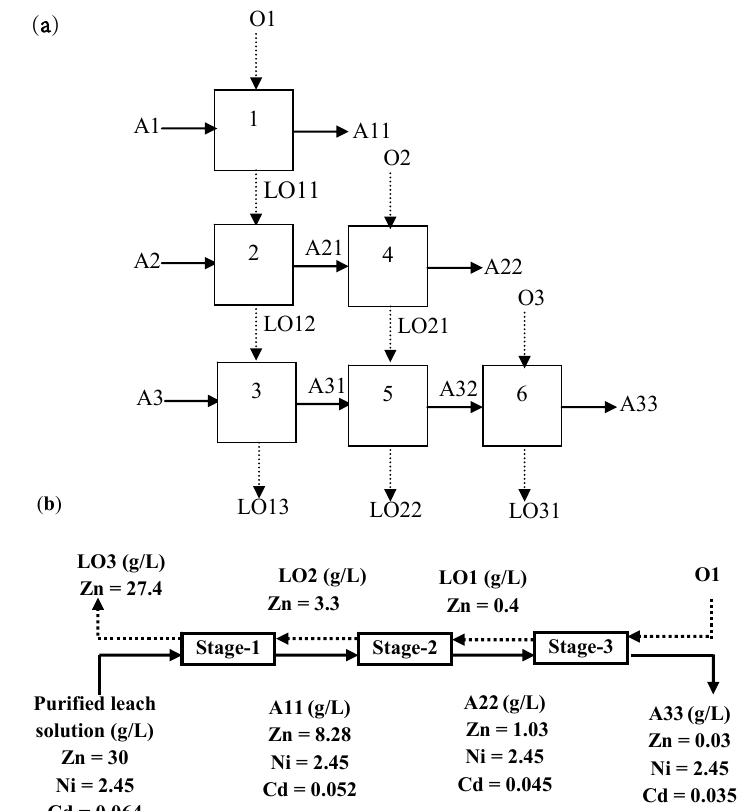
Figure 8. ( a ) Simulation model for counter current extraction of zinc from purified leach solution using mixture of 1 mol/L HDEHP and 0.5 mol/L tris-2-ethylhexyl amine (TEHA) as extractant. ( b ) Counter current extraction showing concentration of metal ions in the aqueous and loaded organic phases at different stages.